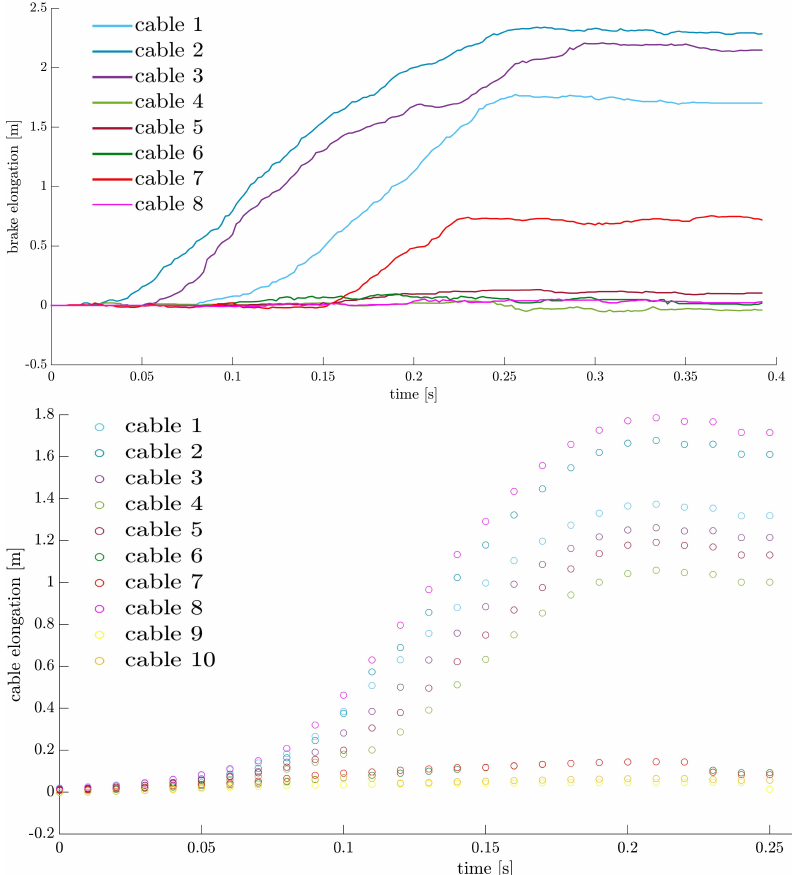
Figure 11. Above : Experimental brake elongation (off-centre impact) as a function of time. Below : Numerical brake elongation (off-centre impact) as a function of